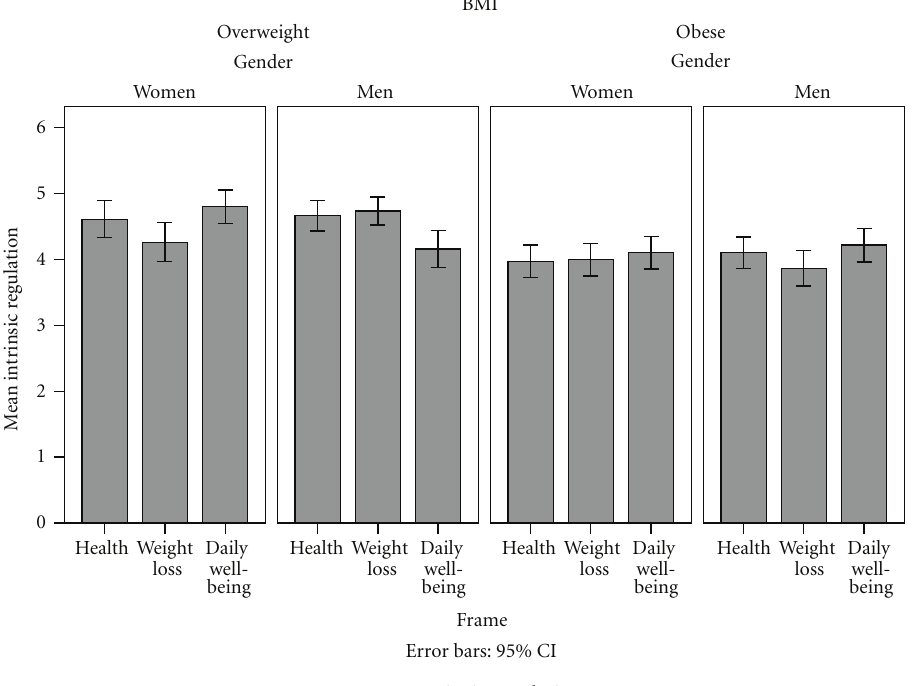
Figure 5: Intrinsic